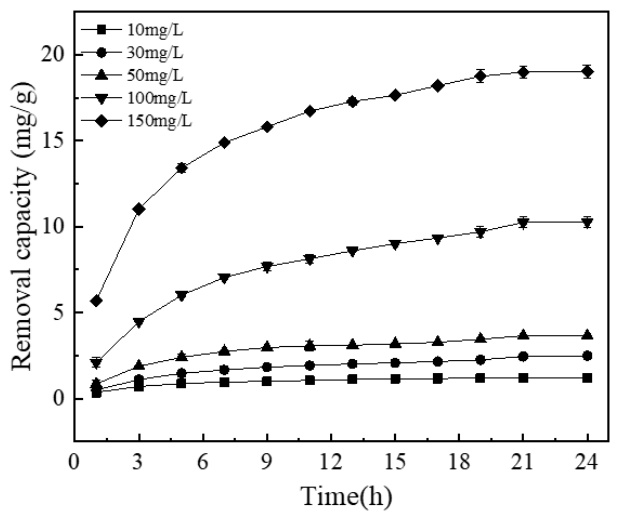
Figure 7. Influence of initial concentration and reaction time on TP removal effect (the dosage is 5 g/L, ph = 7).